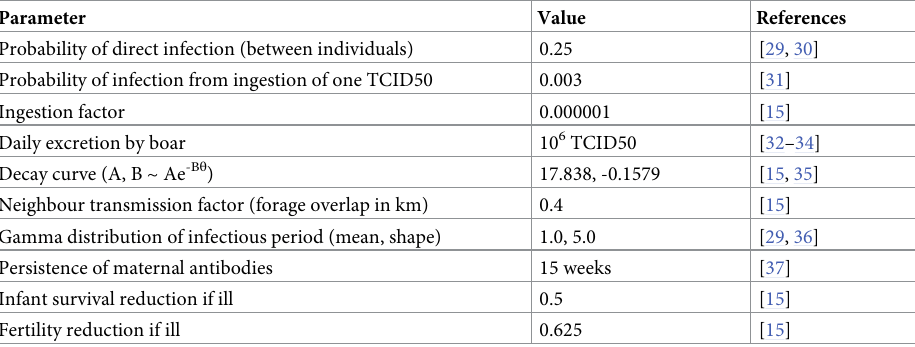
Table 2. Epidemiological parameter values used in the model. Parameter Value Probability of direct infection (between